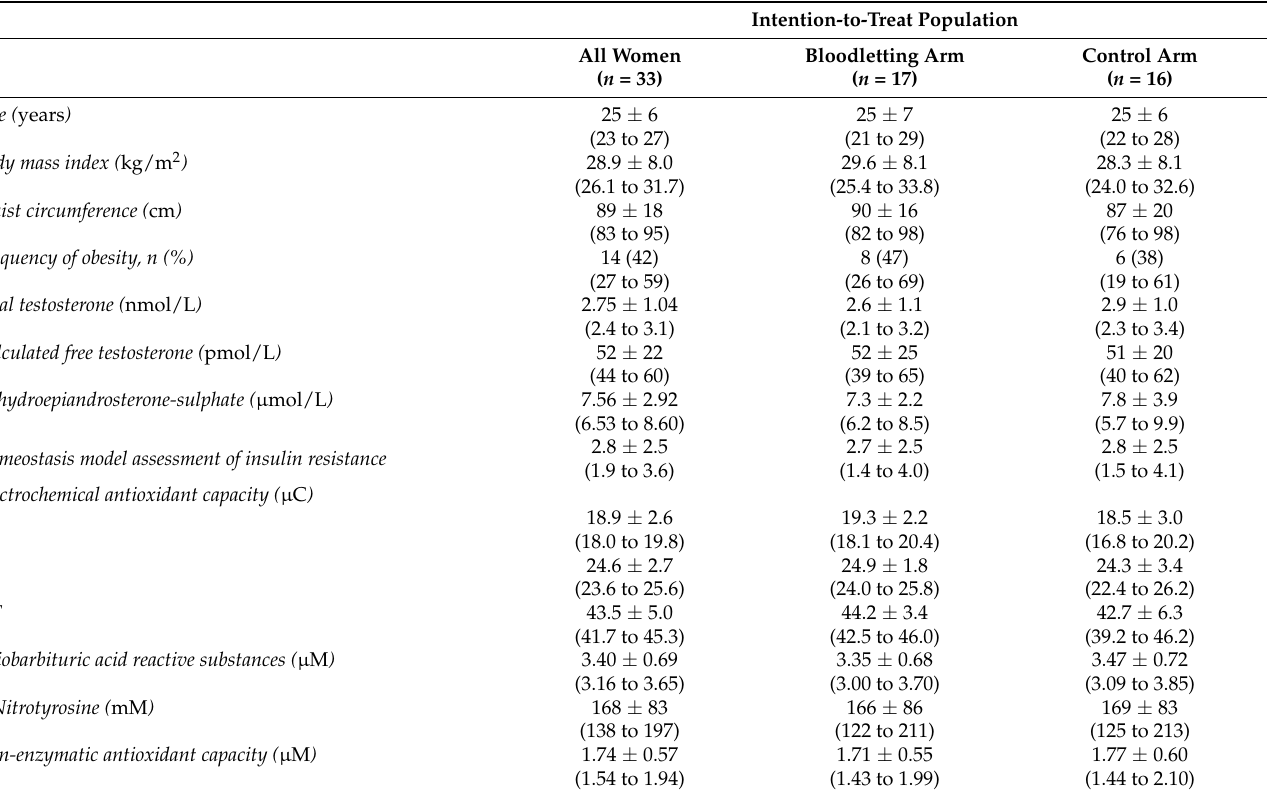
Table 1. Baseline characteristics and fasting plasma redox status of the patients with functional hy- perandrogenism (PCOS or idiopathic hyperandrogenism) randomized to treatment with a combined oral contraceptive pill plus scheduled phlebotomies (experimental arm) or to COC plus observation (control arm). Intention-to-Treat Population All Women Bloodletting Arm Control Arm ( n =